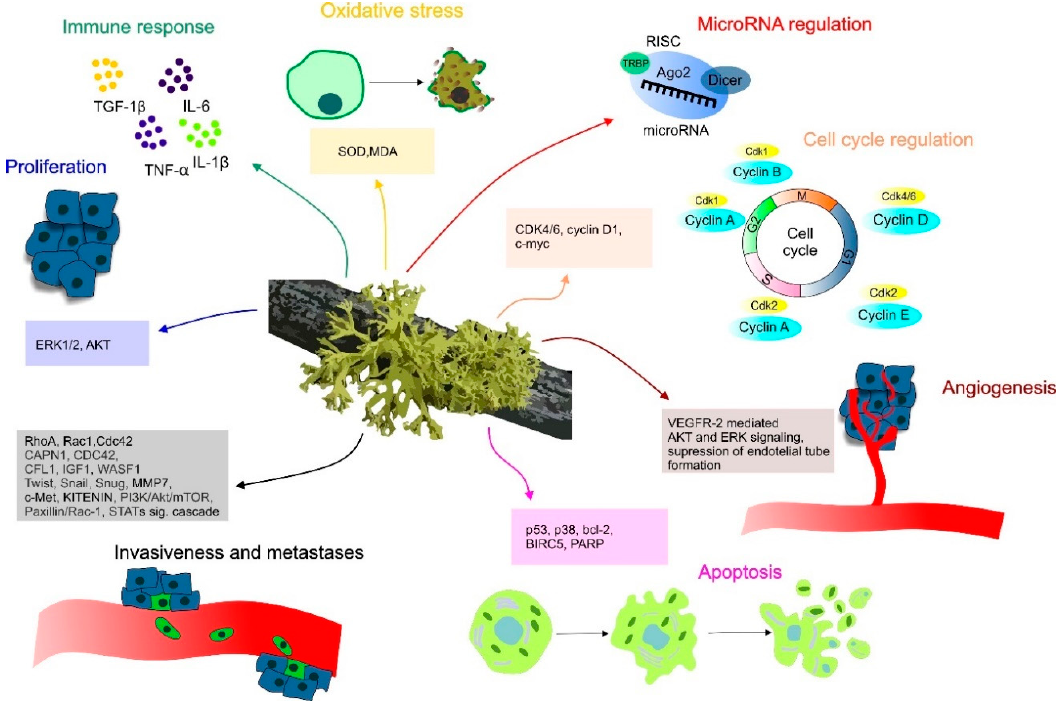
Figure 1. The role of lichens in the modulation of molecular mechanisms associated with cancer.